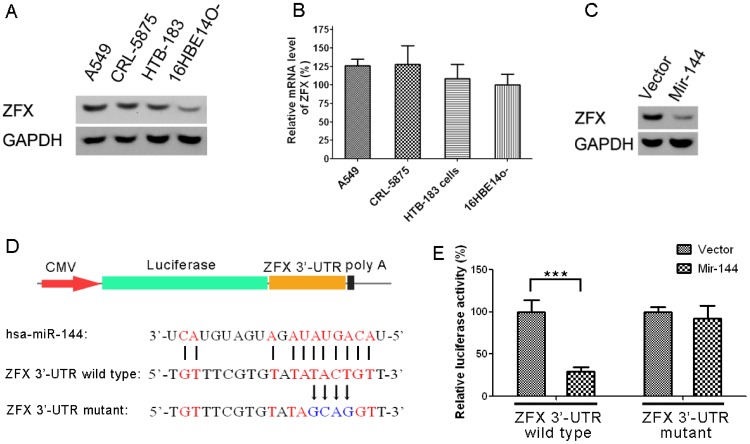
ZFX mRNA and protein expression in the human bronchial epithelial cell line and lung cancer cell lines.The effect of ectopic miR-144 expression on ZFX protein level in A549 cells. A. Relative mRNA expression levels of ZFX in A549, CRL-5875, HTB-183 and 16HBE14o- cells, mean±SD, n = 3. B. Western-blots of ZFX and GAPDH in above cells. C. Western-blots of ZFX and GAPDH in A549 cells with or without mir-144 over-expression. D. The scheme of the luciferase assay using pMIR-REPORT System to evaluate the direct inhibition of mir-144 on ZFX protein expression. E. The different effects of mir-144 on ZFX 3′-UTR and its mutant, mean±SD, n = 5.Mir-144 can efficiently inhibit the luciferase expression by binding to ZFX 3′-UTR, but has no effect on the luciferase expression when the binding sites were mutated on ZFX 3′-UTR.